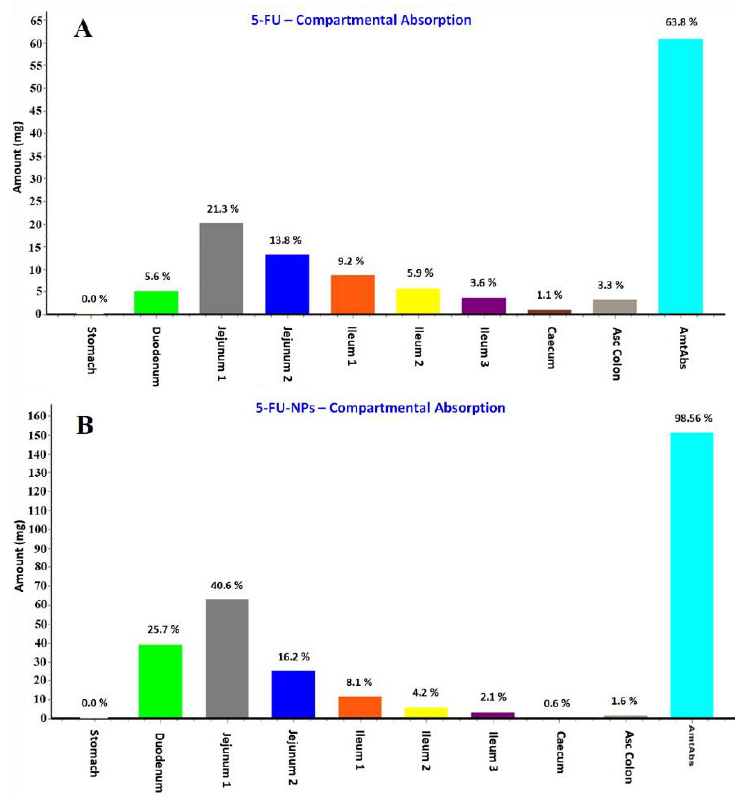
Figure 11. Regional absorption of 5-FU from various segments of the GIT (gastrointestinal tract) predicted by the GastroPlus ® simulation and prediction tool. ( A ) 5-FU; ( B ) 5-FU loaded NPs.